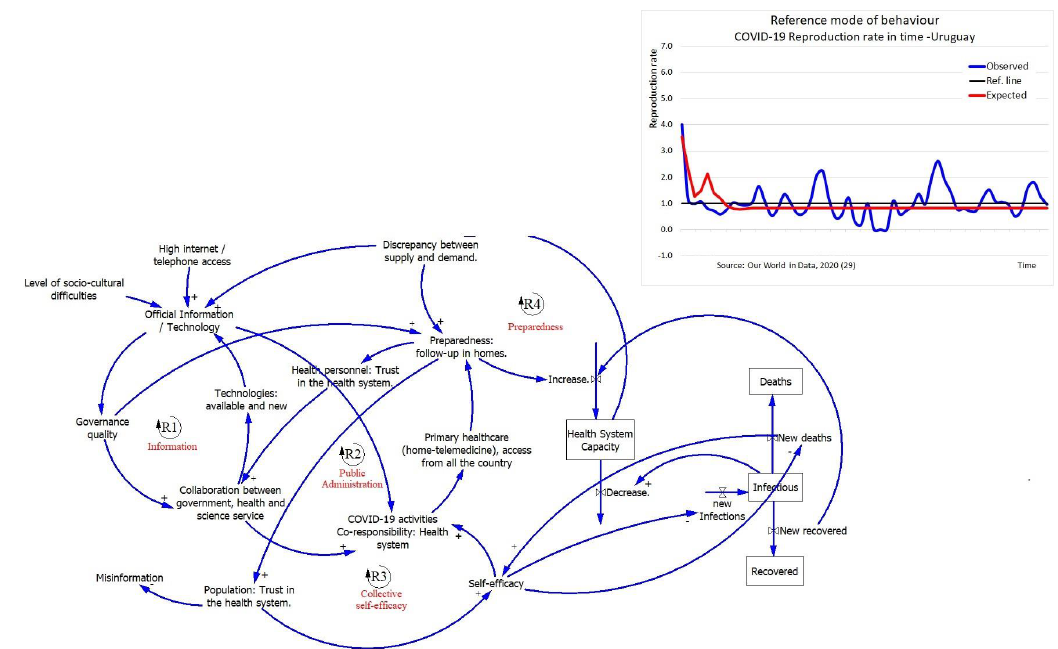
Figure 3. Reference mode and GMB Uruguay. Solid lines indicate positive relationships while a dotted lines indicate negative relationships. Reinforcing feedback loops are represented by an R, and balancing feedback loops are represented by a B.